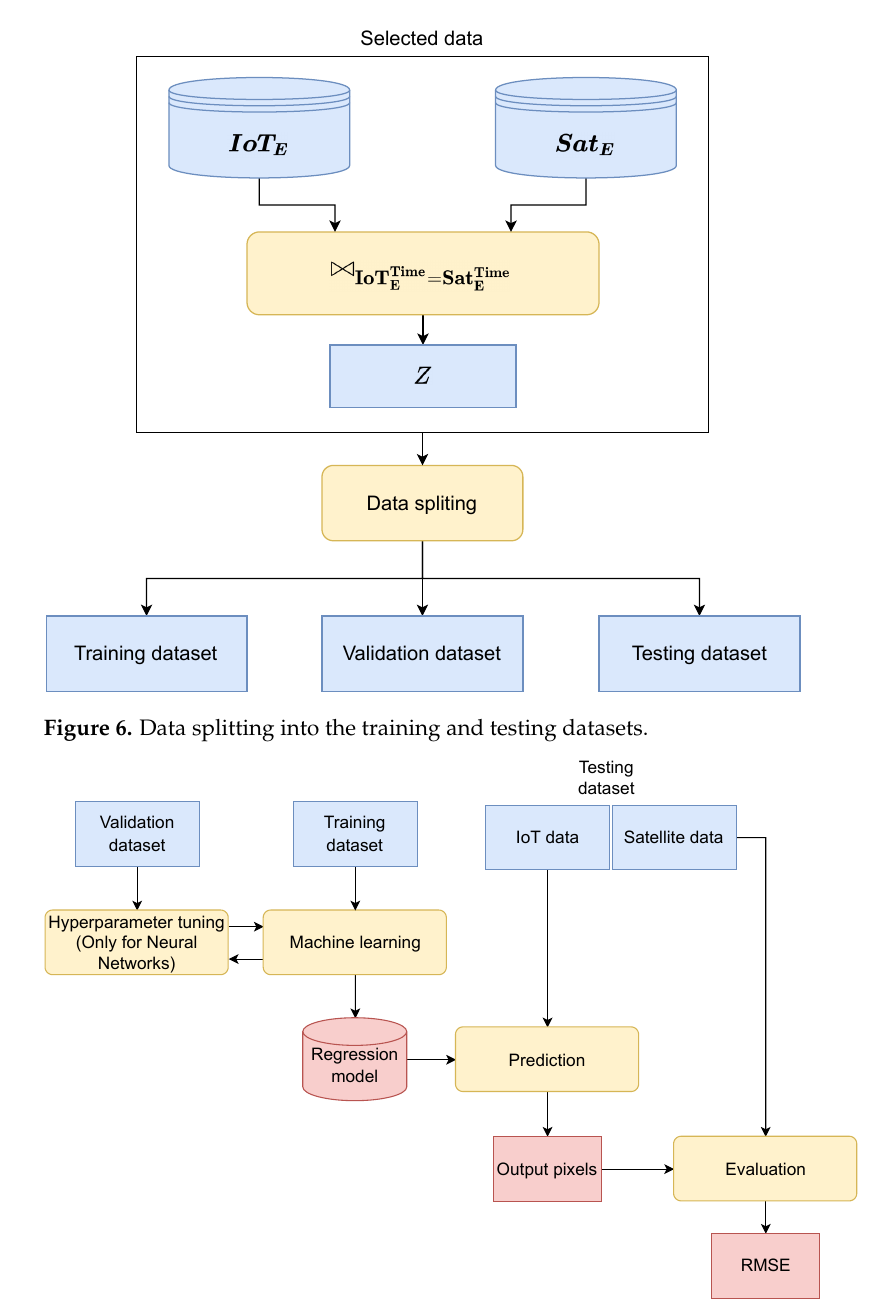
Figure 7. Machine learning and model evaluation